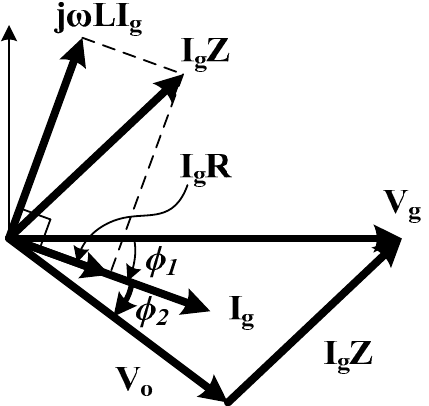
Figure 2. Phasor diagram of T-type three-level PWM converter operation.